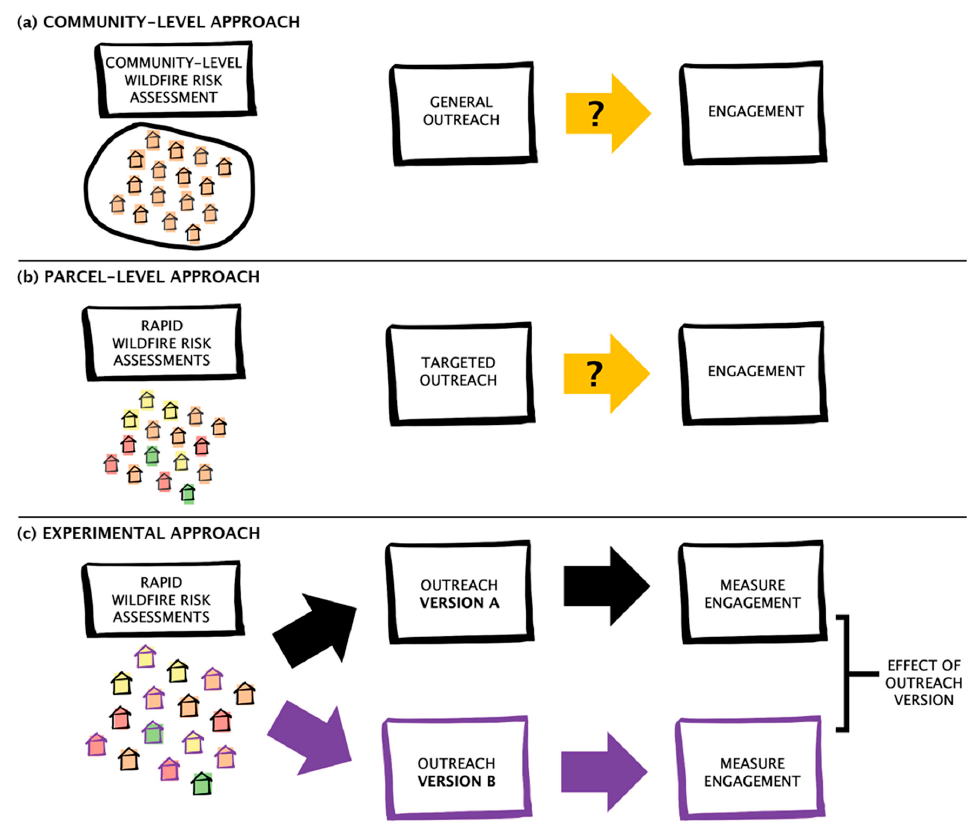
Figure 3. Three approaches to engaging homeowners in wildfire programs. ( a ) The Community-Level Approach relies on general community-level evaluations of risk and does not typically measure effects of outreach on residents’ engagement. ( b ) In the Parcel-Level Approach, programs conduct rapid assessments and use these to target their outreach, but still do not monitor the effectiveness of outreach or residents’ engagement. ( c ) The Experimental Approach embeds research into wildfire program delivery to leverage rapid assessment data in outreach, randomly assign households to different outreach versions, and measure differences in residents’ engagement.